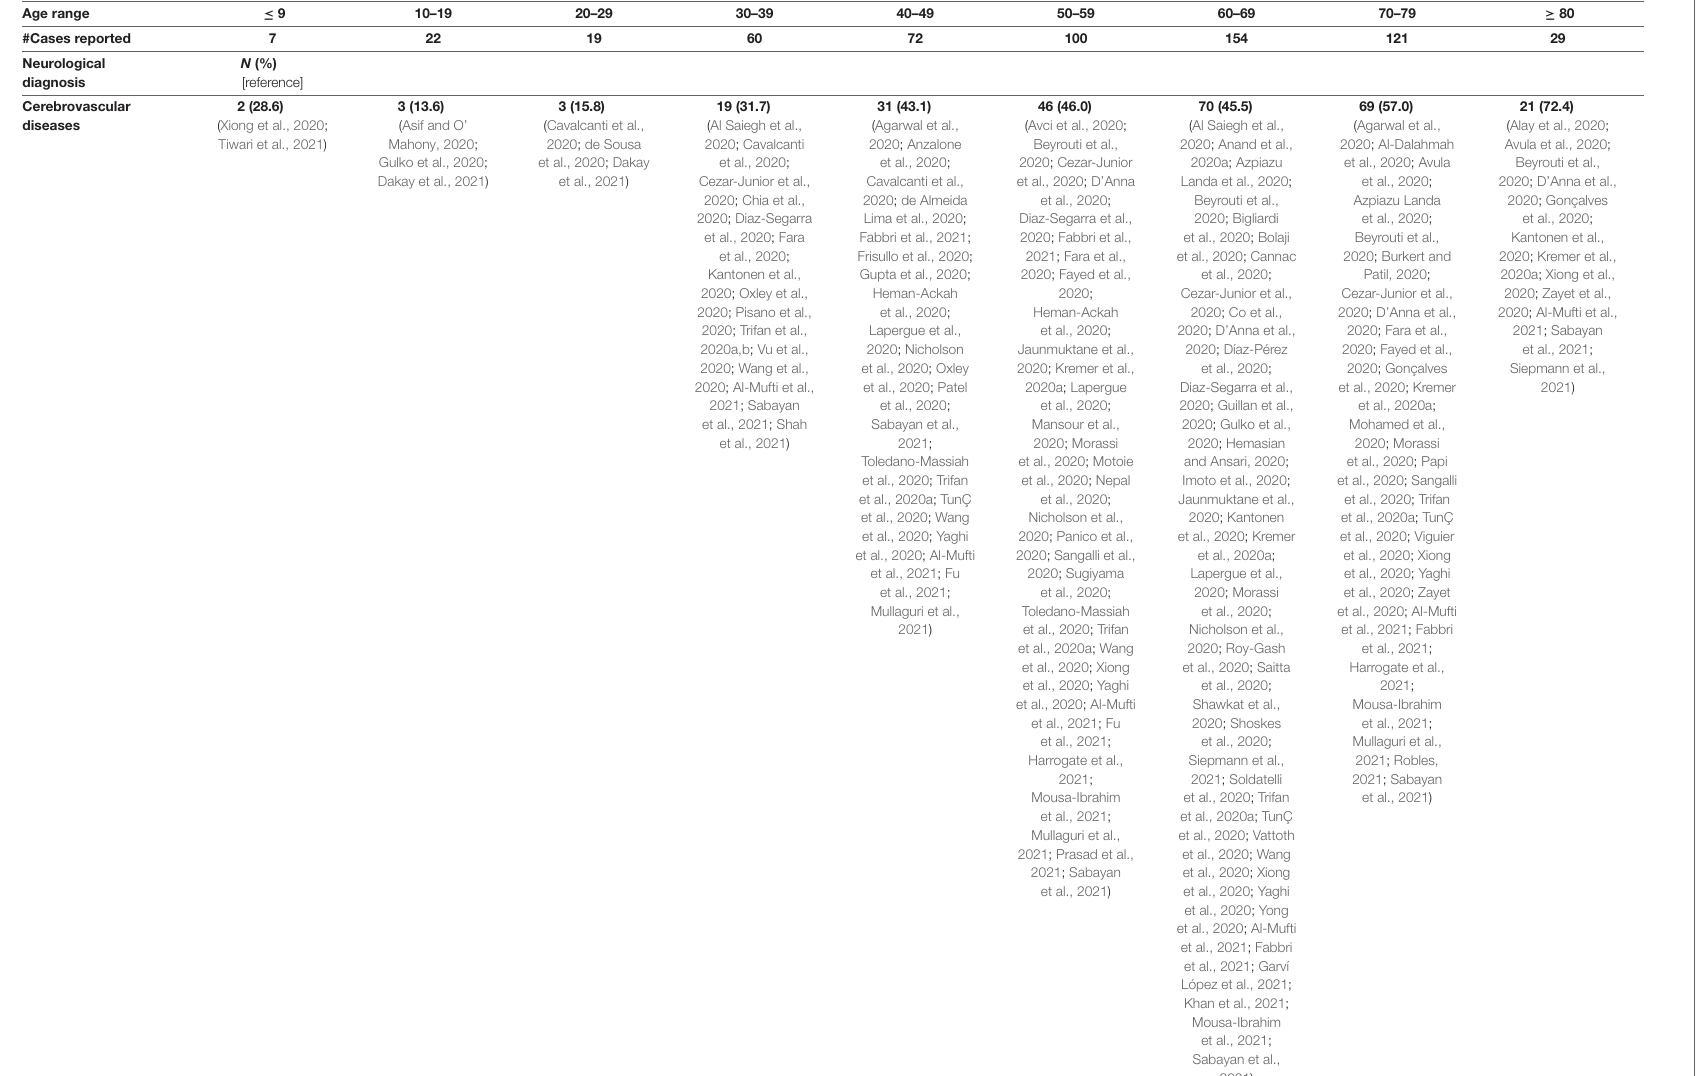
TABLE 1 | Total number ( n = 584) and percent of each neurological condition reported in patients diagnosed with COVID-19 per decade of